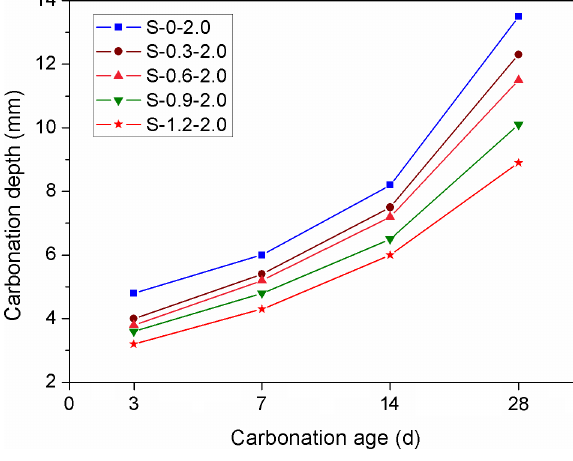
number of small pores and microcracks inside the